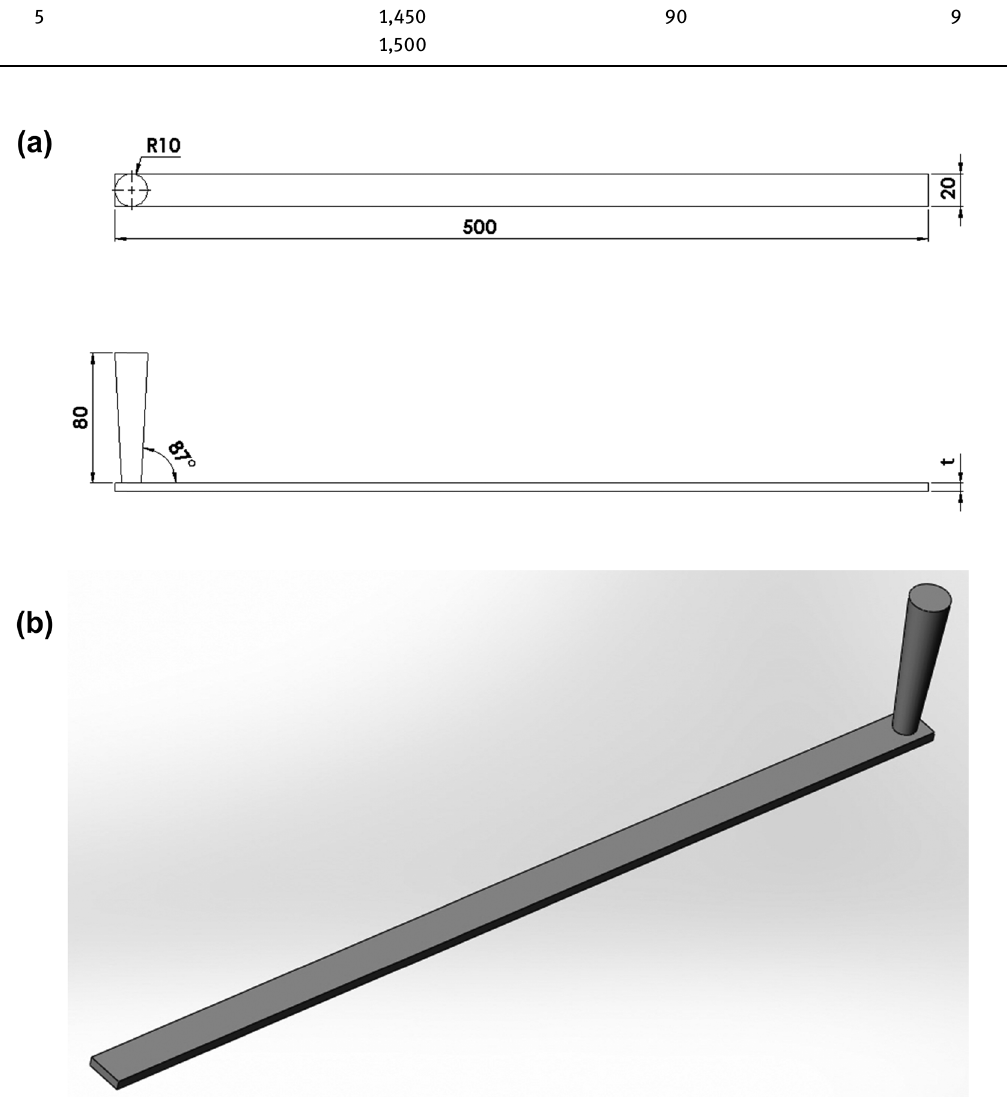
Figure 1: ( a ) Fluidity test model measurement and ( b ) solid model image used in fl uidity